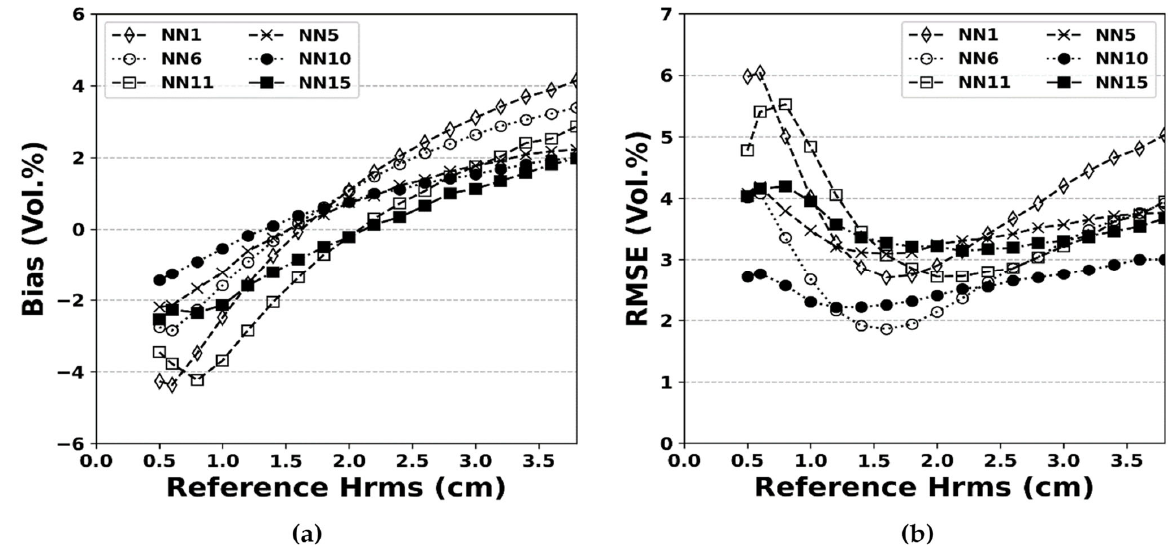
Figure 8. Error evolution on the SSM estimations as a function of reference Hrms using simulated C-band data through NNs without Hrms in the input vector (NN1 without a priori information on SSM, NN6 with a priori information on SSM in dry to slightly wet soil conditions, NN11 with a priori information on SSM in very wet soil conditions) and NNs with noisy Hrms in input (NN5 without a priori information on SSM, NN10 with a priori information on SSM in dry to slightly wet soil conditions, NN15 with a priori information on SSM in very wet soil conditions). ( a ) Bias (estimated SSM − reference SSM); ( b ) RMSE on SSM.